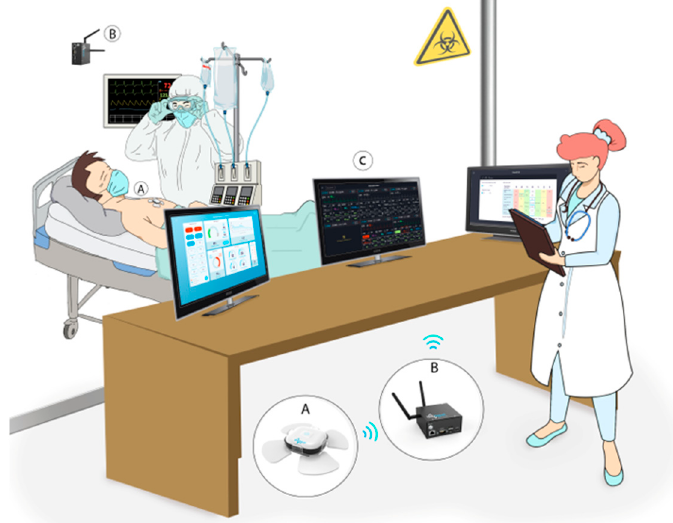
Figure 1. The remote patient monitoring (RPM) system is deployed in isolation units. The chest-patch sensor was attached to all moderate to severe COVID-19 patients included in the study. This RPM system provides automatic measurement of 15 vital signs every 5 to 15 min. Data is transmitted through Bluetooth low energy (BLE) from the sensors ( A ) to gateways ( B ) installed in the isolation units and from there through Wi-Fi or a SIM card to a cloud-based medical management application available to health care providers on any web platform ( C ), allowing to monitor all admitted patients at once. The monitor shows the vital signs in real-time, provides alerts and has an integrated early warning score system.